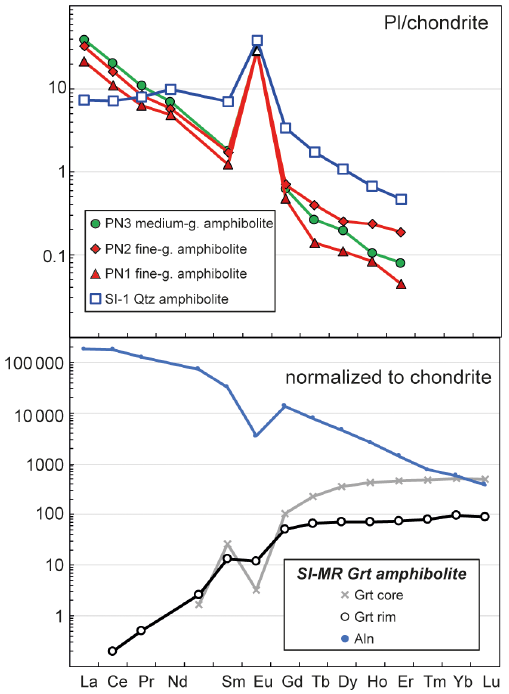
Figure 9. REE compositions normalized to chondrite (Anders and Ebihara, 1982) of plagioclase, garnet and allanite.